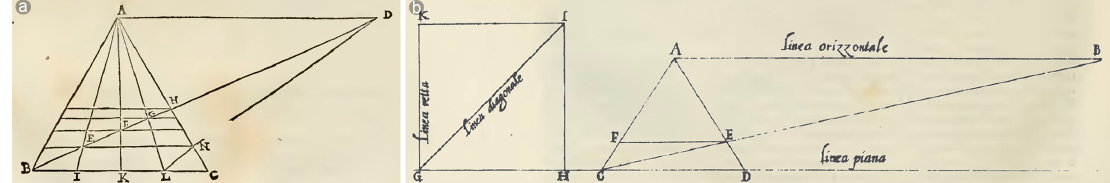
Figure 10. Relationship between perspective of squares and their diagonals, converging in a point on the horizon ( b ), as previously shown in an exercise of plane geometry ( a ) in theorem